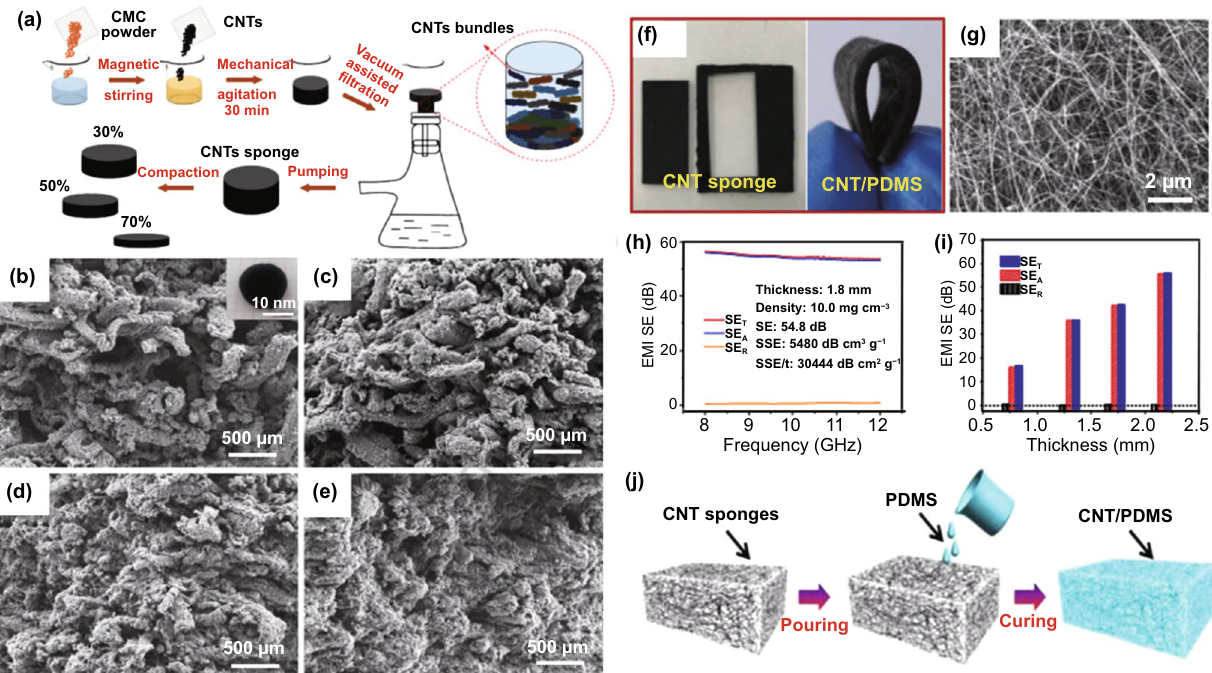
Fig. 7 a Preparation process of composite CNT sponge with different compaction ratios. b-e SEM images of CNT sponges with varying com- paction ratios [117]. Copyright © 2018 Elsevier Ltd. f Photograph of CNT sponges; g SEM image of the CNT sponge. h EMI SE of the CNT sponges in X-band. i Average SE T , SE R and SE A of CNT sponge with different thicknesses. j Schematic illustration of the fabrication of the